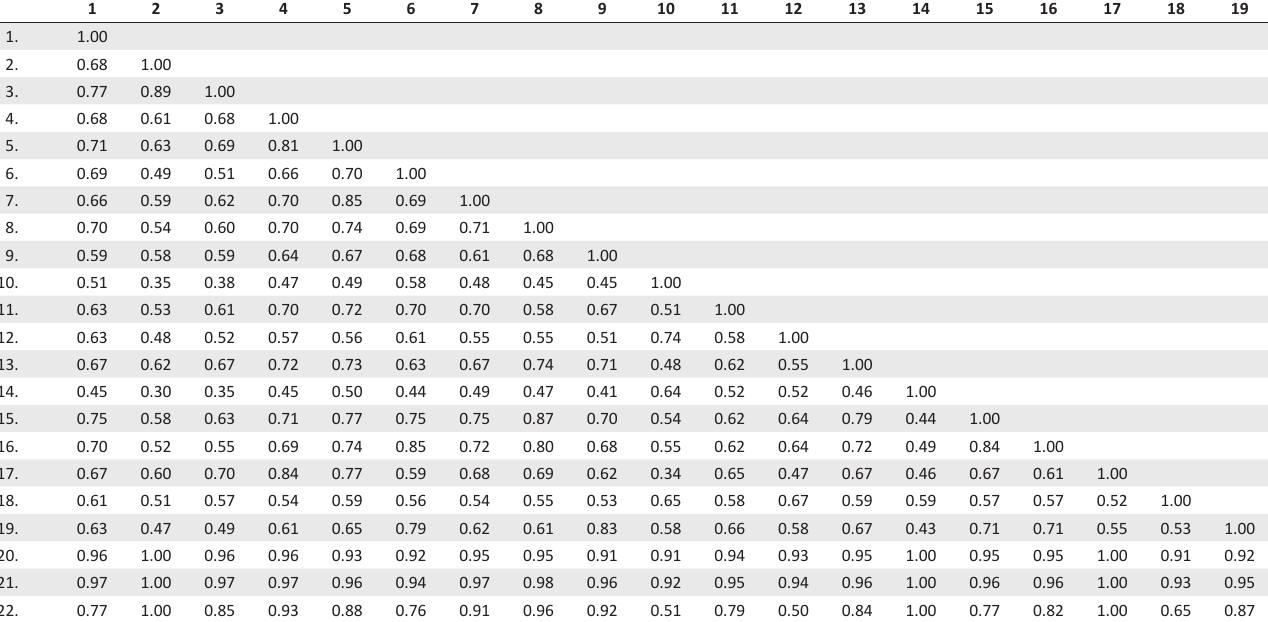
TABLE 2: Scale properties with the following legend – Awareness (1), Citizen (2), Competency (3), Connectivity (4), Convenience (5), Data (6), Flexibility(7), Municipal government (8), Industry( 9), Information (10), Motivation (11), Operation (12), Municipal e-government (13), Service (14), Strategy (15), System (16), Technology